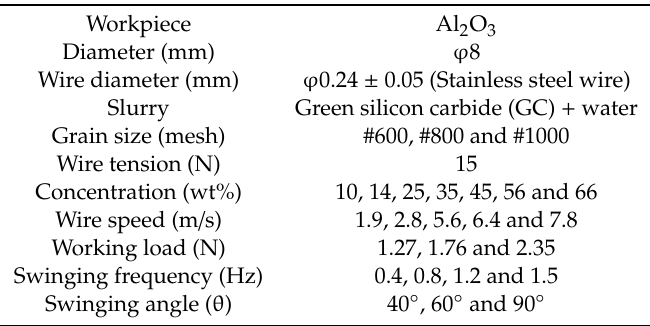
Figure 2. ( a ) Model of swinging wire-sawing and ( b ) contact between the wire and the workpiece. Table 1. Experimental conditions.